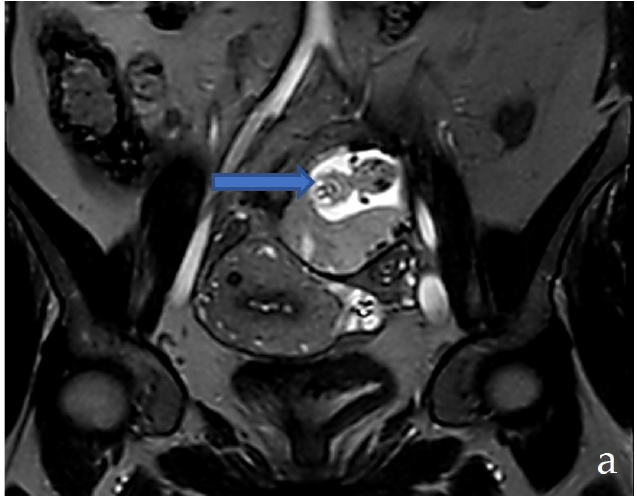
Figure 3. Ultrasound examination of the fetus cardiac activity.